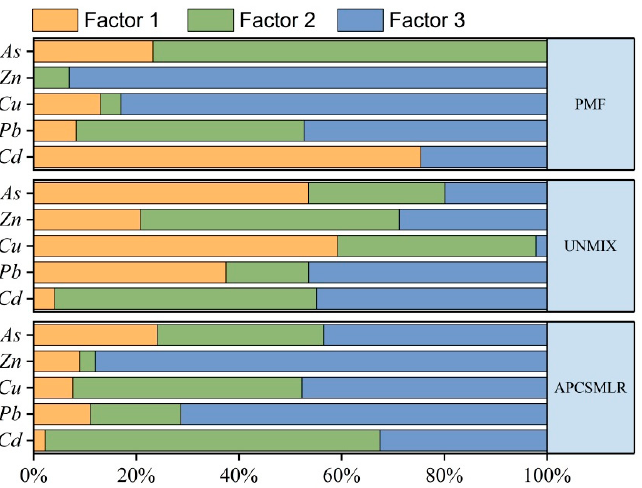
Figure 8. Source contribution of each factor derived from PMF, UNMIX, and APCS/MLR.